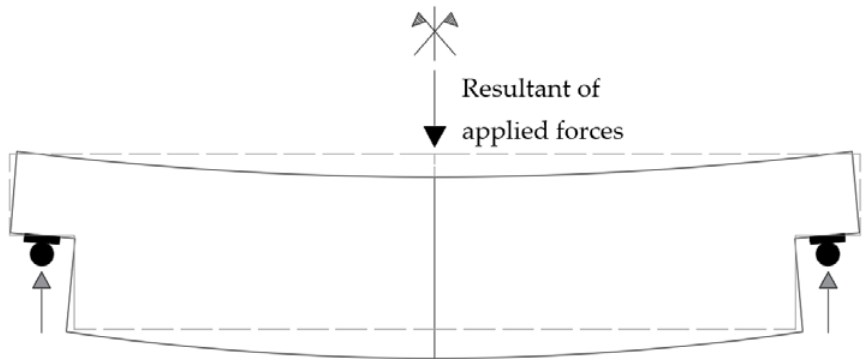
Figure 11. Simplified geometry of the specimen and boundary conditions.